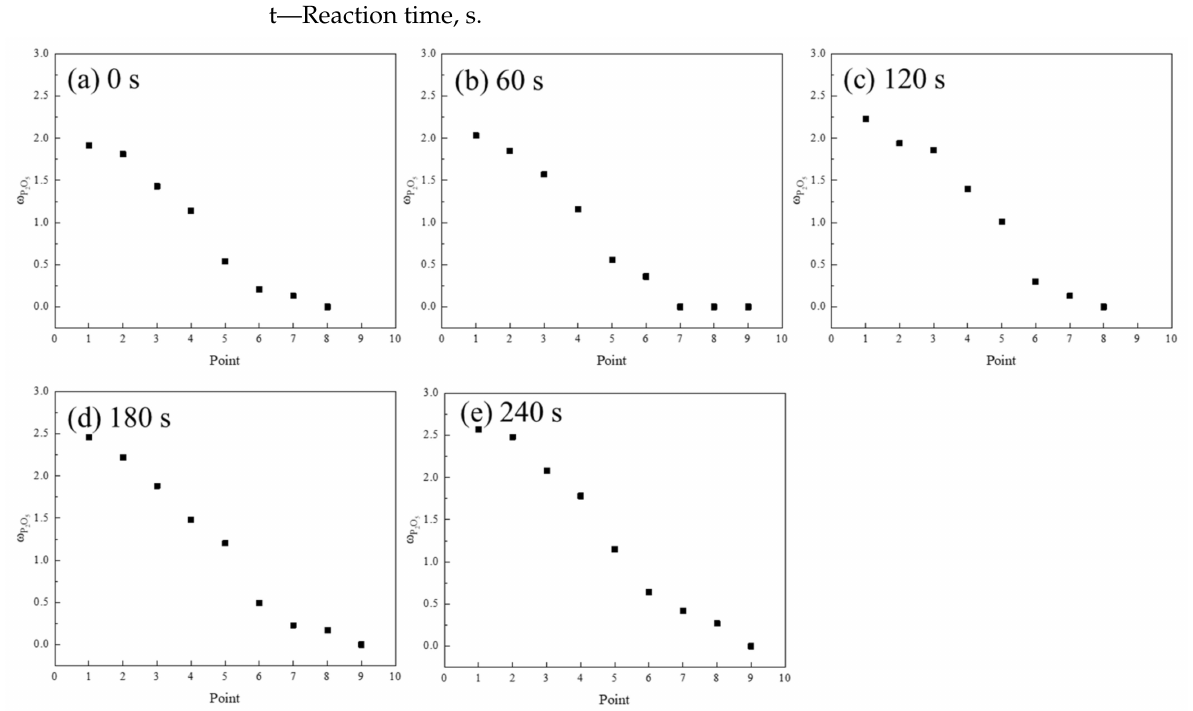
Figure 5. P 2 O 5 contents in C 2 S particles with different times in Figure 4: ( a ) 0 s; ( b ) 60 s ( c ) 120 s; ( d ) 180 s; ( e ) 240